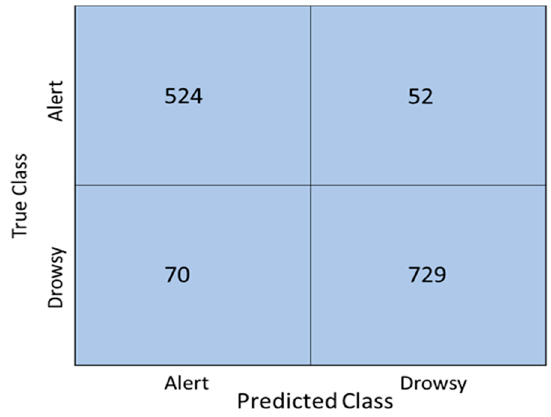
Figure 4. Confusion matrix of the optimized ensemble AdaBoost method.